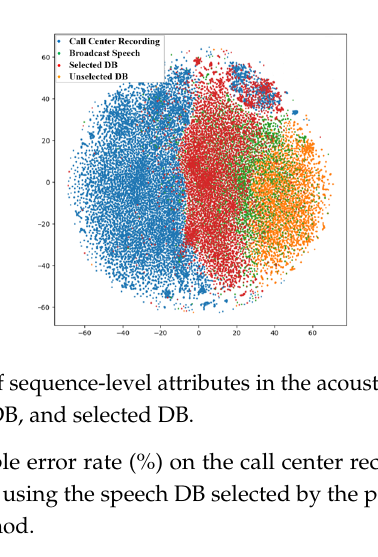
and the random selection method.